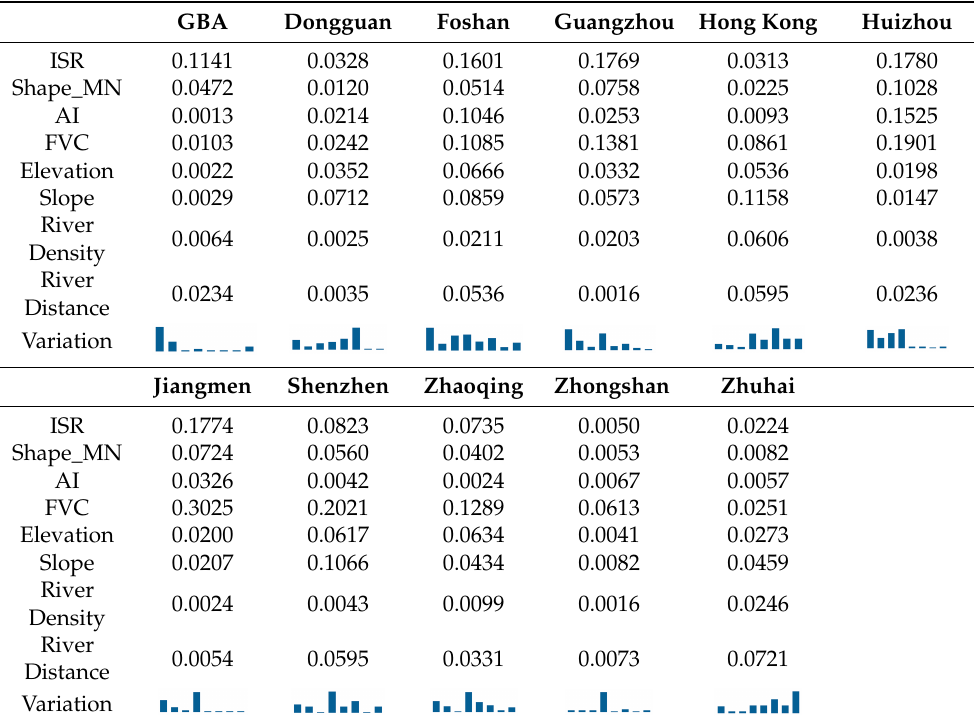
Table 3. The impact of driving factors on rainstorm waterlogging in the whole GBA and local cities.